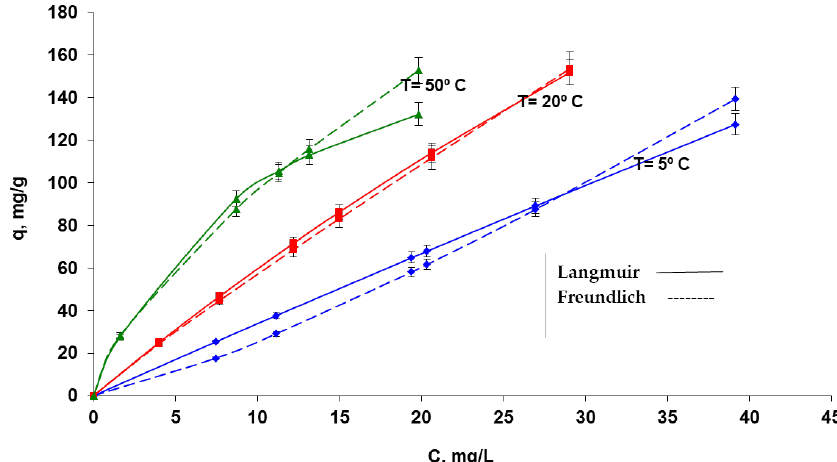
Figure 8. The biosorption isotherms (Langmuir I and Freundlich) of Methylene Blue dye on the hydrogel OxC25 biosorbent. Conditions: pH = 11, contact time = 24 h, amount of biosorbent = 0.4 g/L.